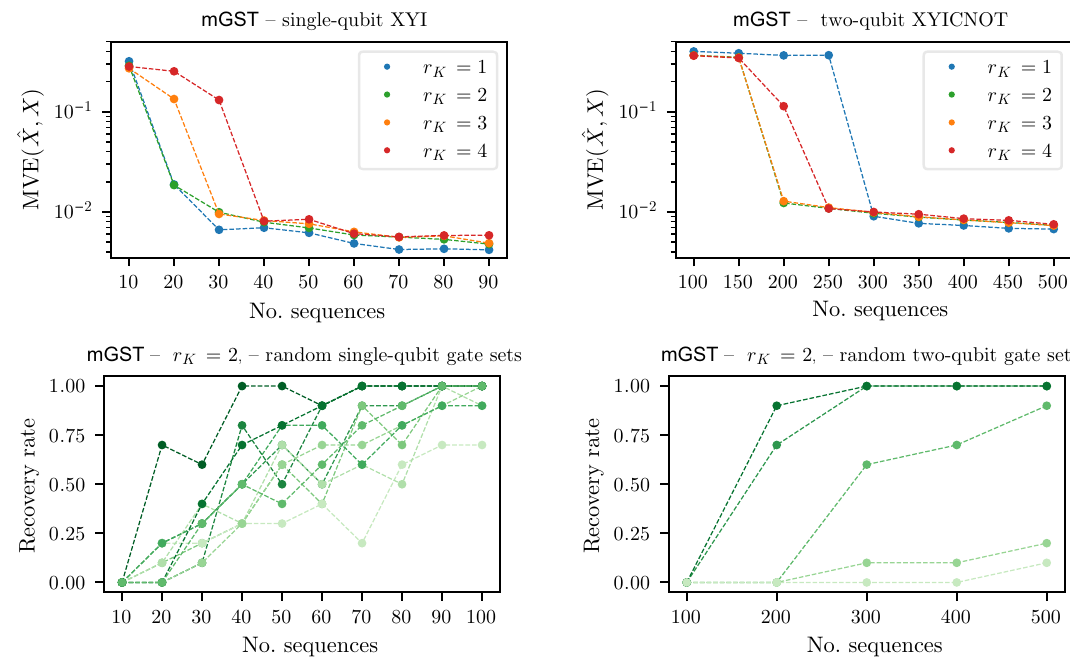
FIG. 3. Median error of mGST run on the least-squares cost function, plotted over the number of sequences for a single-qubit model (top left) and a two-qubit model (top right). Each data point is the median over the results from ten different random sequences. Measurement data for the XYI model—and the XYICNOT gate set—are taken from a noisy version with depolarizing noise of strength p = 0.001 on each gate, depolarizing noise with strength p = 0.01 before measurement, as well as independent random unitary rotations e i γ H with γ = 0.001 and H ∼ GUE on each gate. In the bottom left plot the recovery rates for the reconstruction of different models of three Haar random unitaries are shown. For each gate set, the average over ten draws of random sequences is shown. A gate set is classified as recovered if the MVE falls below 0.03. The bottom right plot depicts the recovery rate for random two-qubit gate sets of the form G = { 1 4 , 1 2 ⊗ U 1 , 1 2 ⊗ U 2 , U 1 ⊗ 1 2 , U 2 ⊗ 1 2 , U 12 } , where U 1 and U 2 are Haar random single-qubit unitaries and U 12 is a Haar random two-qubit unitary. Additionally, each single-qubit and two-qubit gate contains depolarizing noise of strength p = 0.001 and depolarizing noise of strength 0.01 is applied before measurement. The recovery rate is averaged over ten random sequence draws. For all gate sets, the sequences are drawn uniformly at random with sequence length (cid:2) = 7 and m = 1000 samples per sequence. The maximum numbers of initializations are 80, 33, 17, and 10 for Kraus ranks 1, 2, 3, 4, respectively. They are chosen such that the maximal computation time is equal among different